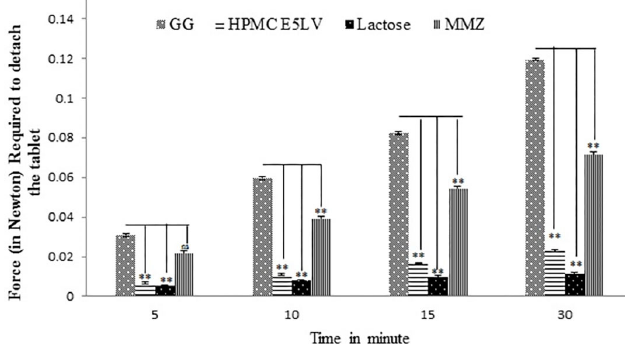
FIGURE 5 - Compression between mucoadhesive strength of Guar Gum and HPMC E5LV (Standard) and MMZ (Test Materials) and Lactose (Control). Values are expressed as mean